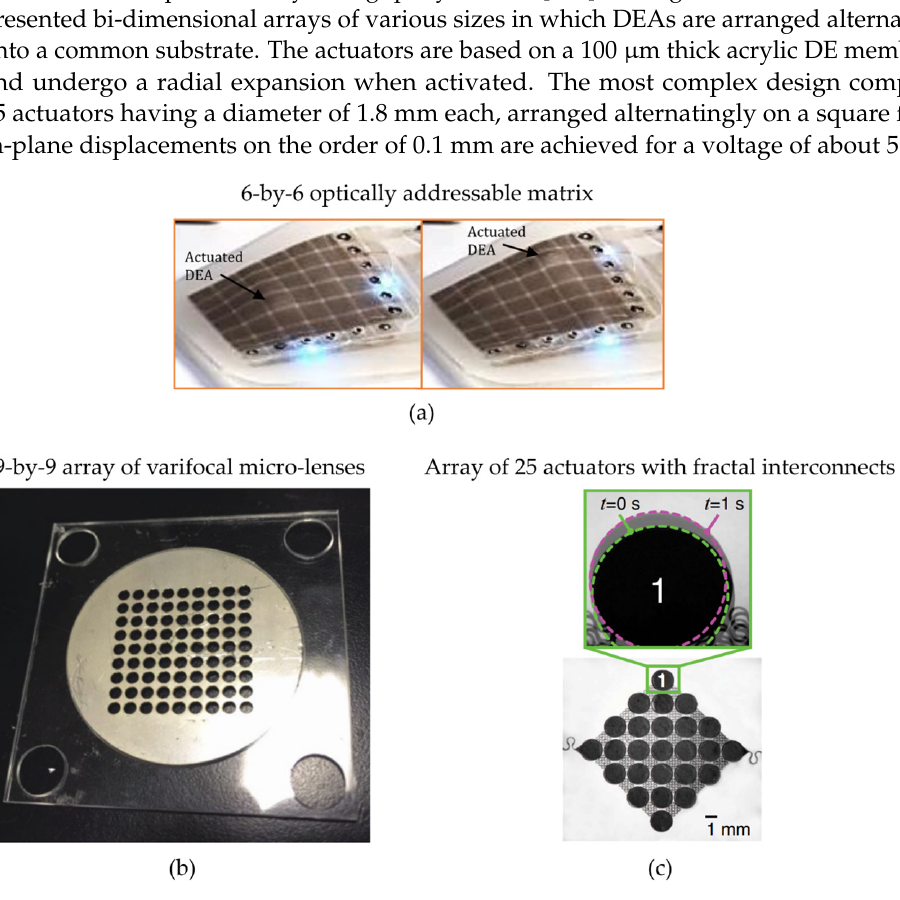
Figure 10. Examples of two ‐ dimensional DEA arrays operating out of plane: ( a ) 6 ‐ by ‐ 6 optically